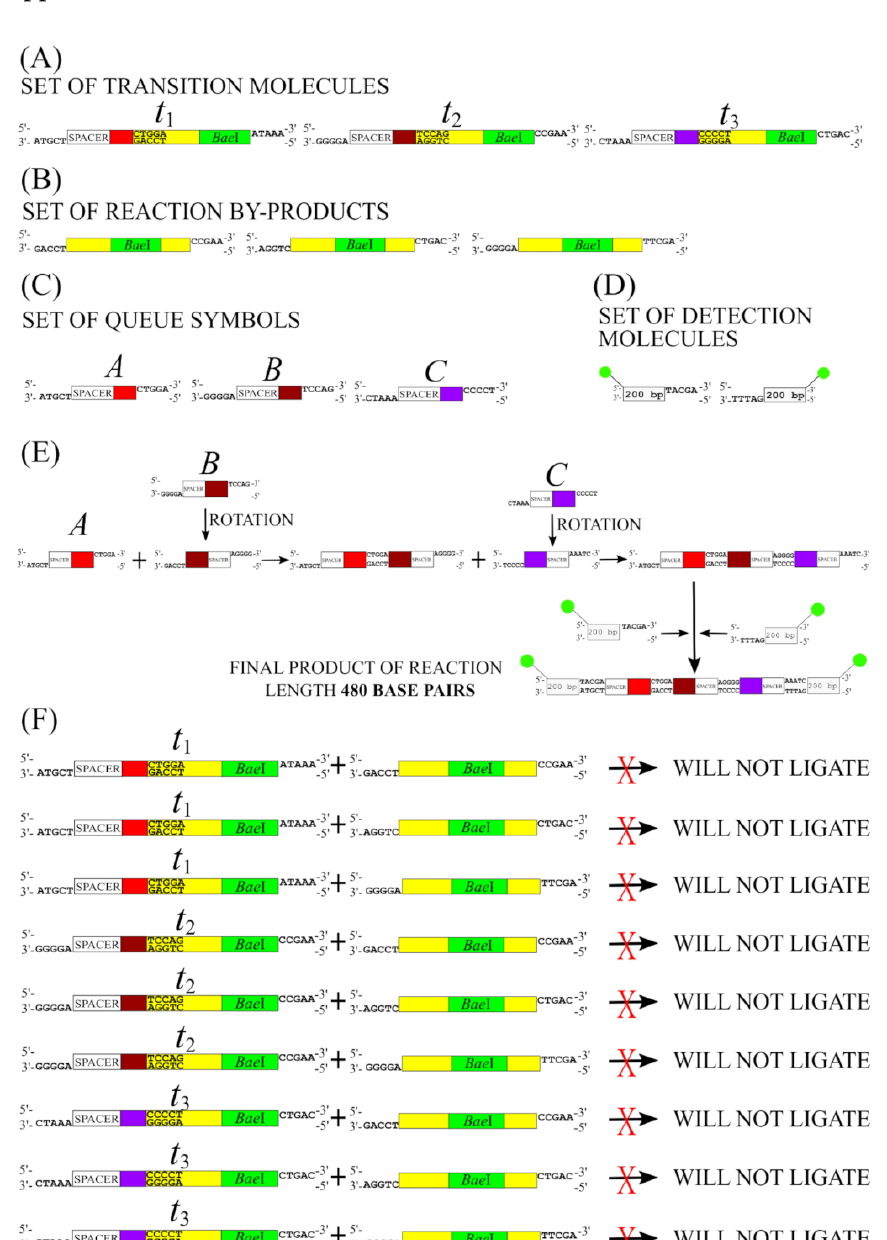
Figure A1. The list of DNA chains that are formed during the action of a biochip—an example: ( A )—the set of all transition molecules; ( B )—the set of all reaction by-products formed during the alternating action of type IIB restriction endonuclease (more specifically, Bae I); ( C )—the set of all queue symbols. ( D )—the set of all detection molecules; ( E )—the process of biomolecular queue symbols ligation; ( F )—the set of all reactions in which DNA molecules are not ligated together. Abbreviations: A , B , C (in italic text)—the queue symbols of a biomolecular computer; t 1 , t 2 , t 3 , t 4 , t 5 —molecular software. The color markings are described in Figure